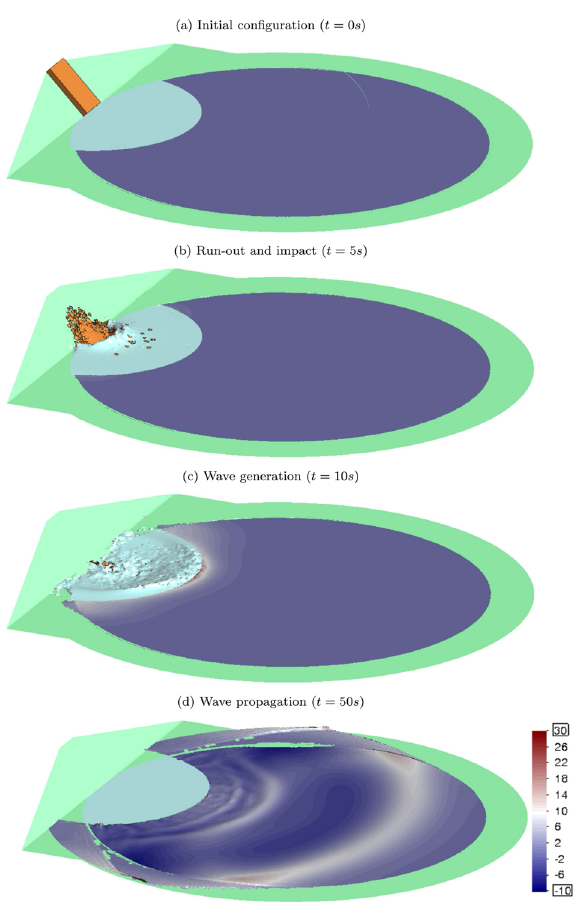
Fig. 13 Landslide in a representative lake. Global representation of the LGW. The NFS domain is plotted until the SW interface and only the geometry is shown. For the FFS, results for the free surface elevation are depicted. Dimensions in m